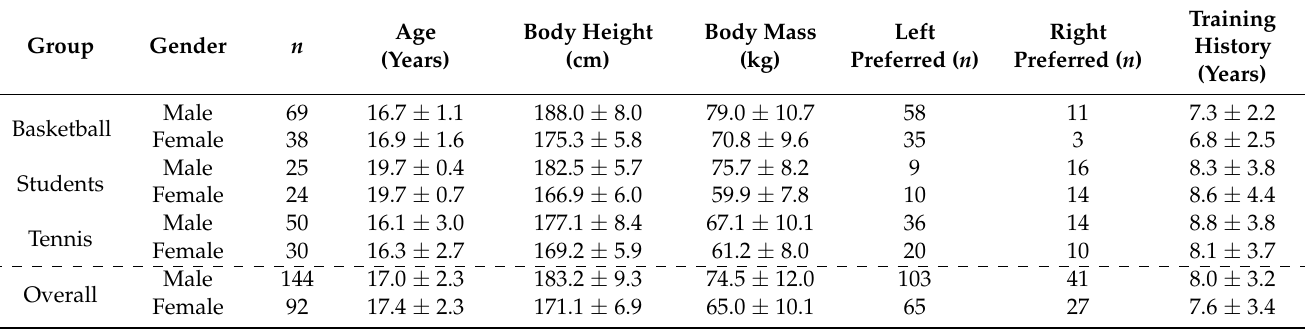
Table 1. Characteristics of